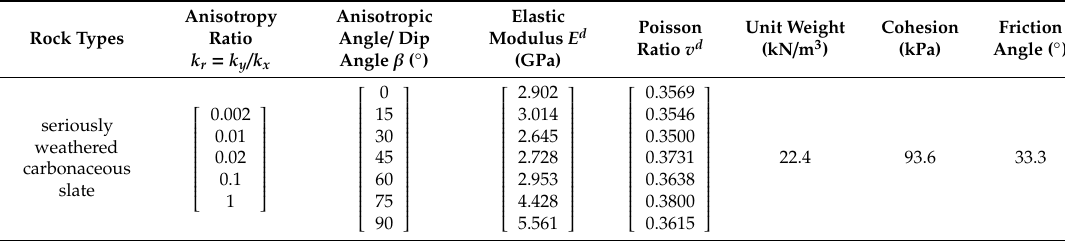
Table 2. Di ff erent calculation conditions.